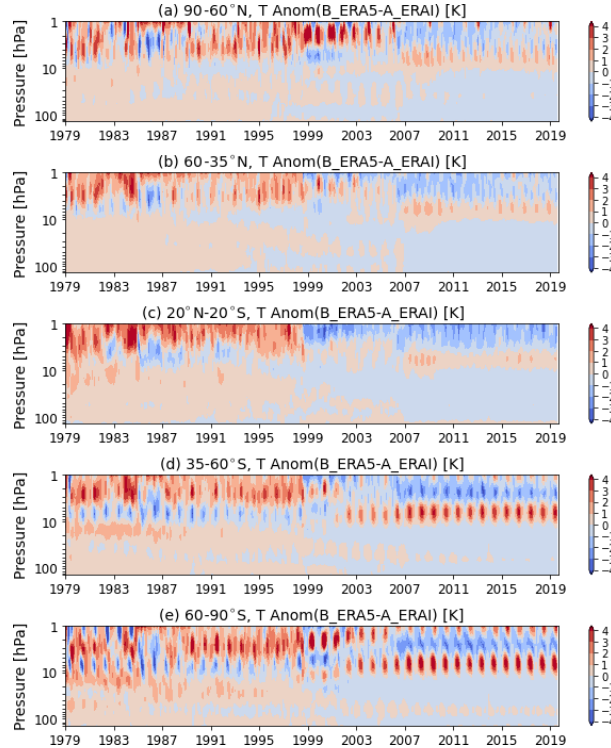
Figure 7. Pressure–time evolution of the relative differences (%) in ozone anomalies between A_ERAI and B_ERA5 over 1979–2019 (August) for different latitude regions (a) 90–60 ◦ N, (b) 60–35 ◦ N, (c) 20 ◦ N–20 ◦ S, and (d) 35–60 ◦ S and (e) 60–90 ◦ S.